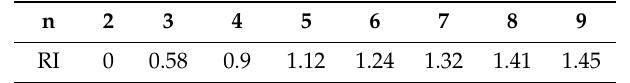
Table 2. Demonstrate the calculated values of Random consistency index (RI) provided by Saaty [33].